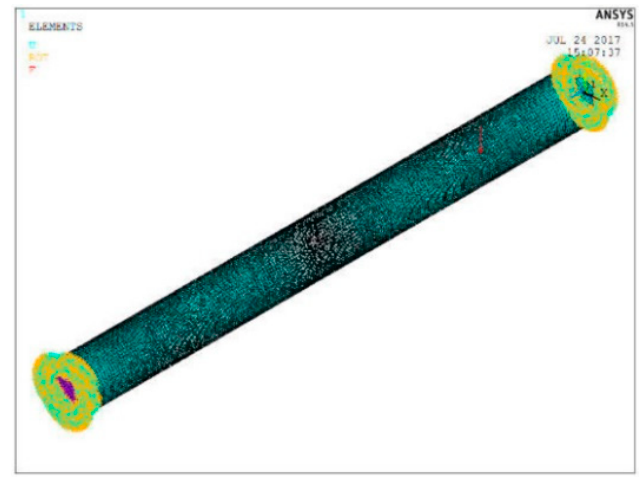
Figure 10. Pipeline modeling from [140] , Copyright 2018, MDPI.